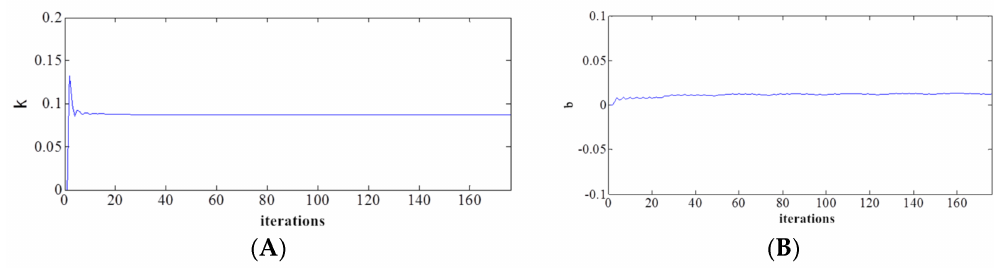
Figure 2. Identification result of parameters for basic regression prediction model. ( A ) Identification result of parameter k ; ( B ) Identification result of parameter b .